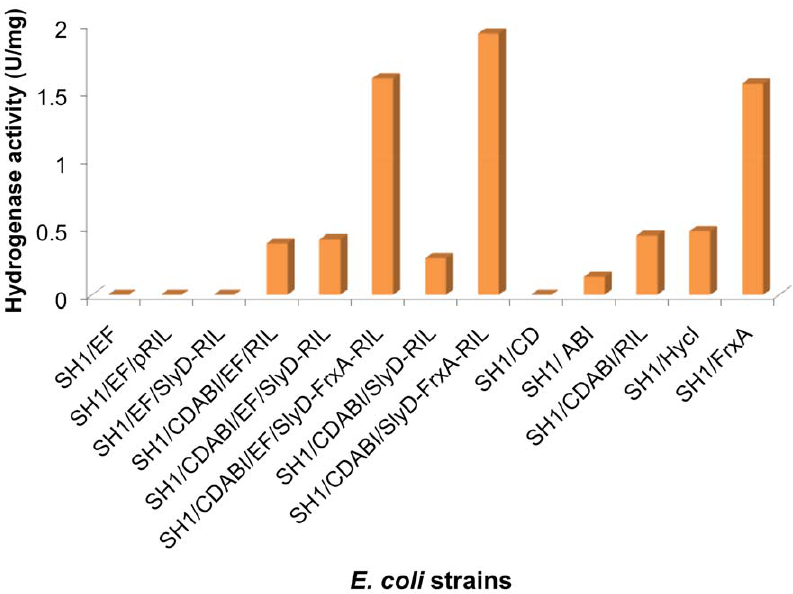
Figure 5. Analysis of the P.furiosus maturation proteins required to produce active rSHI in E.coli . The specific activities are shown for rSHI in cell extracts of E. coli resulting from the co-expression of different Pf processing genes in E. coli MW1001. Bars indicate MV-linked specific activity ( m mol H 2 evolved min 2 1 mg 2 1 ). All cell extracts were heated for 30 min at 80 u C prior to assay.